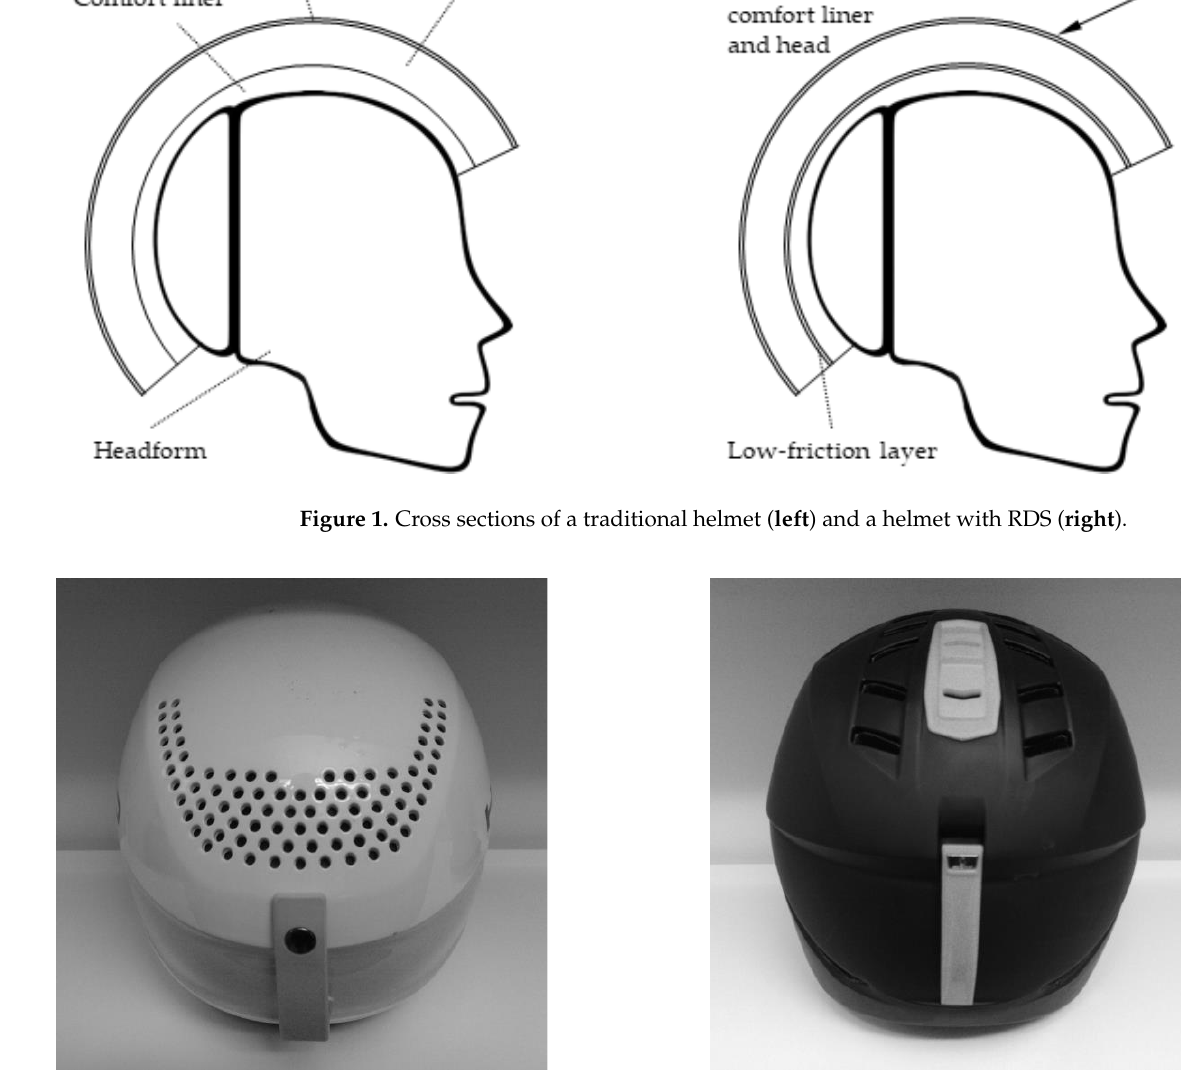
Figure 2. Rear views of the ski racing helmet ( left ) and recreational alpine sports helmet ( right ). Note that the recreational alpine sports helmet, both with and without RDS, had the same shell design.